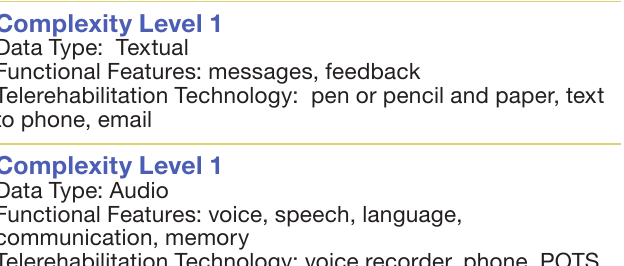
Table 3. Complexity of telerehabilitation